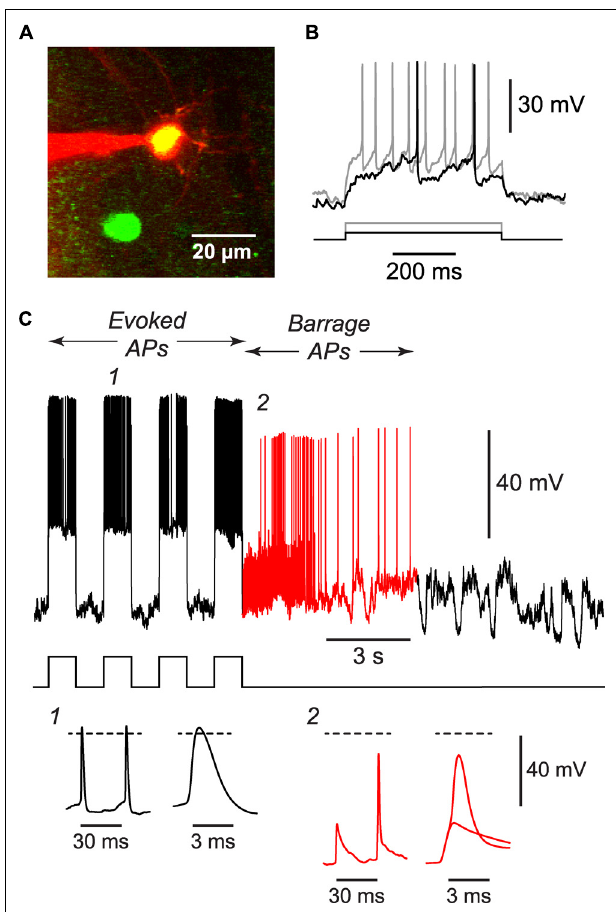
FIGURE 4 | BF can be induced in NG cells in vivo . (A) , 2-photon microscope image showing a whole-cell patch electrode (red) on a NG cell in upper layer 2 of the somatosensory cortex of an anesthetized GAD67-GFP mouse.This image is a merge of two z-projections, one (green) showing GFP, the other (red) showing the Alexa 594 dye in the solution in the patch electrode. (B) , Responses of the cell in (A) to depolarizing current steps (black, 50 pA; gray, 120 pA) showing the delayed firing and lack of accommodation typical of NG cells. (C) , Example of the BF induced by a train of current steps (240 pA for 1 s; stimulus pattern at bottom) in the NG cell shown in panels (A,B) . Red portion of trace indicates period of BF. Insets, bottom, show action potentials at the numbered locations in the main panel, displayed on two different time scales.The spikelet and full-height spike in inset 2 are shown superimposed on an expanded timebase on the right. Dashed lines, 0 mV. Elevated electrode resistance attenuated the AP amplitudes in this experiment, and difficulties in adjusting the bridge balance accounts for the apparent larger peak amplitude of evoked APs (see Materials and